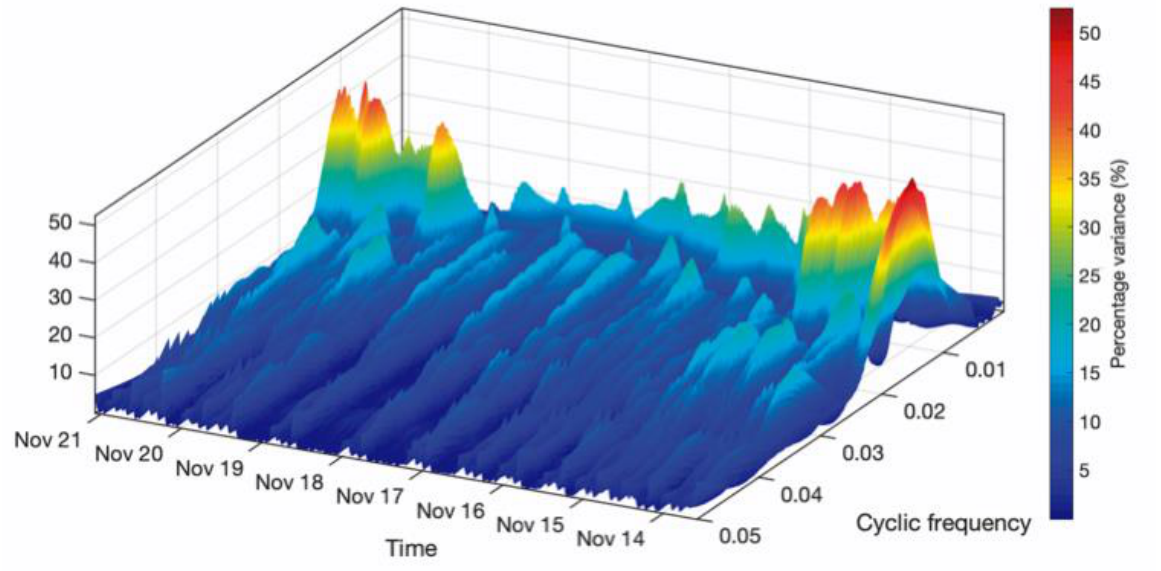
Figure 10. Detail in 3D for the lowest cyclic frequencies in the LSWA